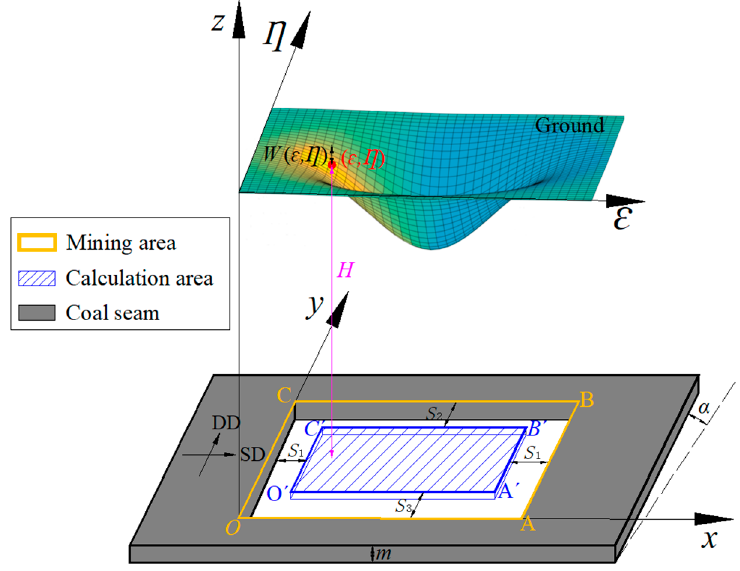
Figure 1. Coordinate system used by PIM-based coal mining subsidence prediction. DD and SD denote dip direction and strike direction respectively.